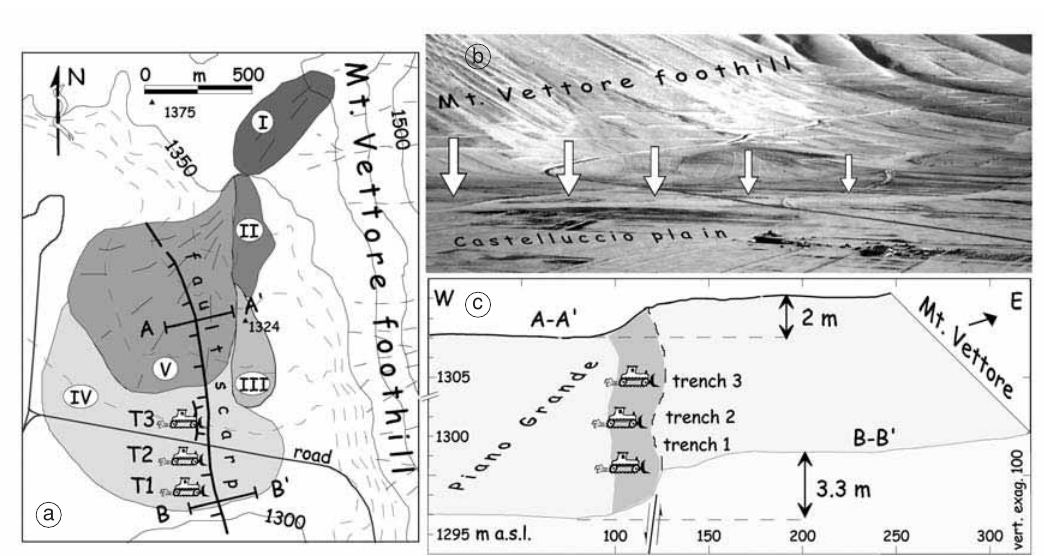
Fig. 4a-c. a) Geomorphological map of the Castelluccio alluvial fan: the fan resulted from the deposition dur- ing five different alluvial phases. b) Panoramic view of the scarp on the alluvial fan (note the slope of the road when it crosses the scarp). c) 3D view of the scarp (vertically exaggerated), location of the trenches and scarp height as derived from the profiles A-A (cid:118) and B-B (cid:118) reported in fig.